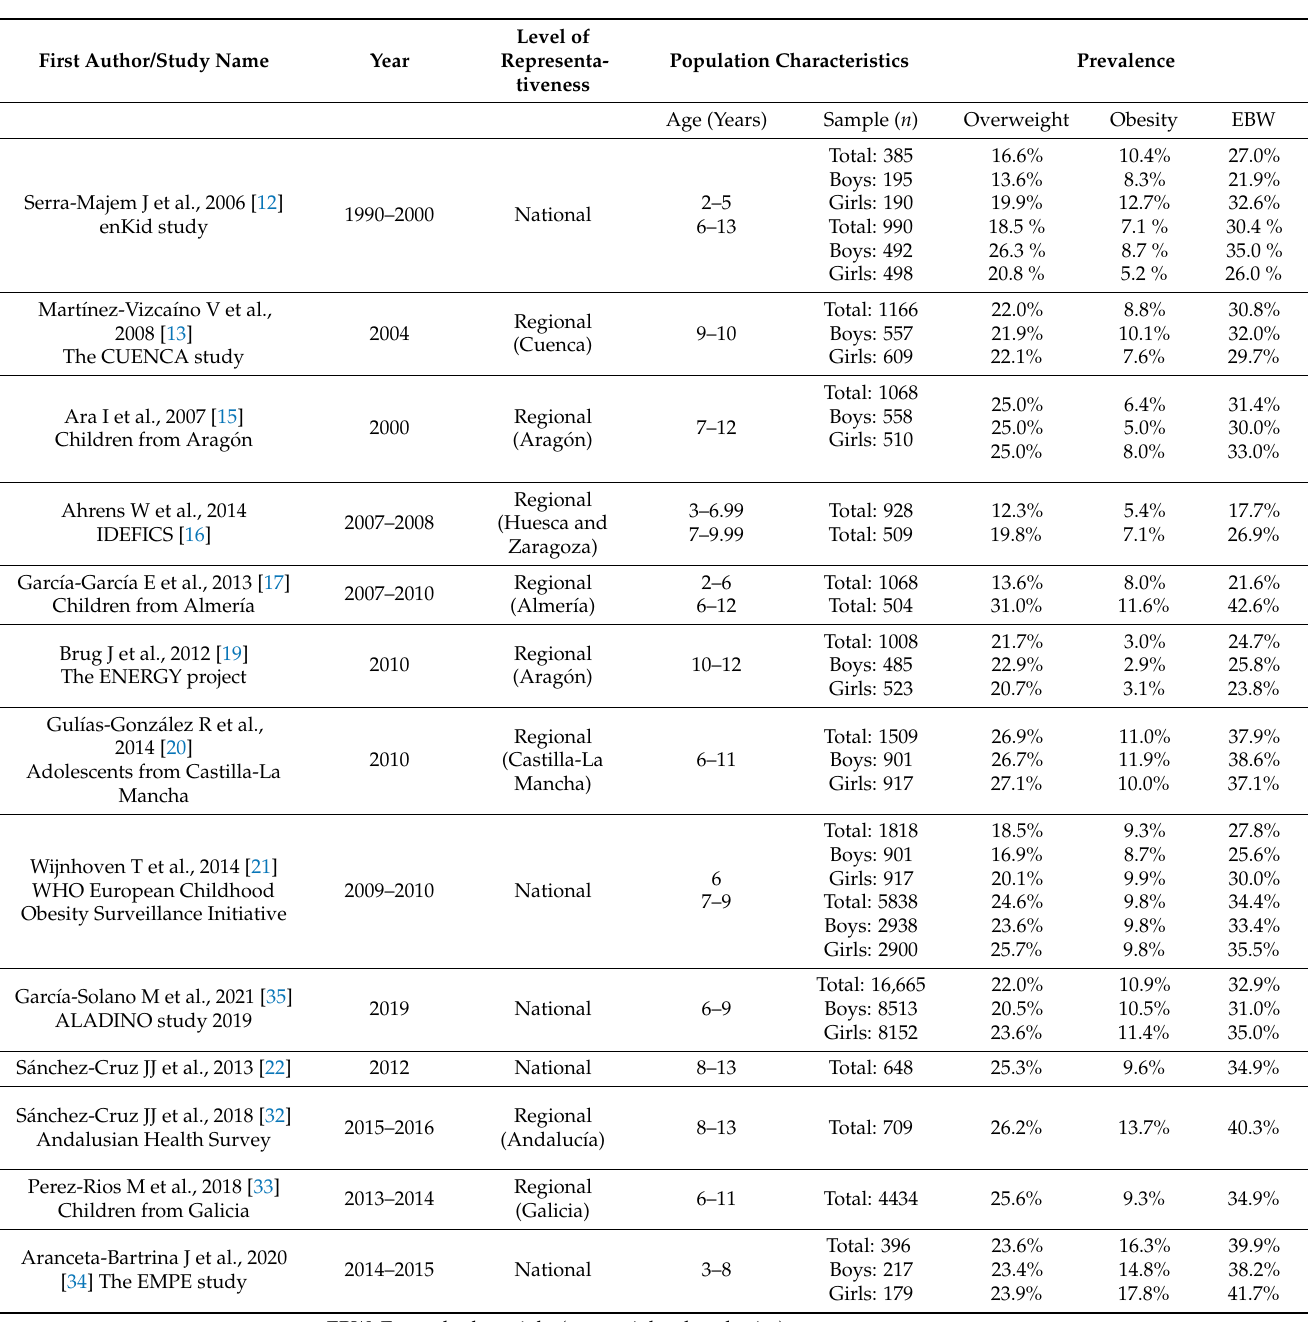
Table 1. Characteristics of studies ( n = 13) included in the systematic review of prevalence of overweight, obesity and excess body weight (overweight plus obesity) in Spanish children from 1999 to